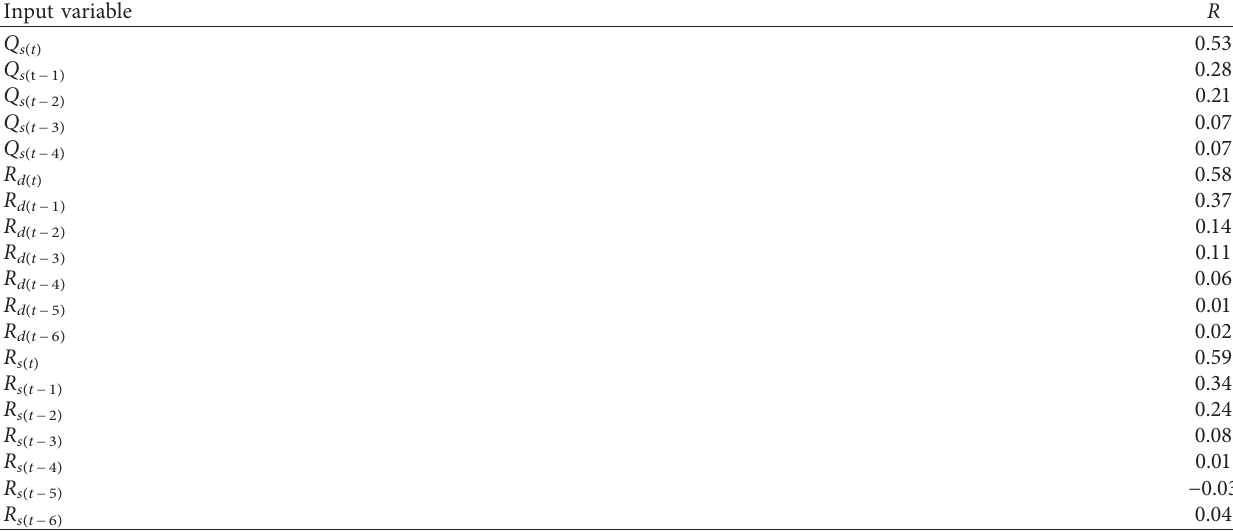
Table 2: The correlation obtained between the input variables and SSL.